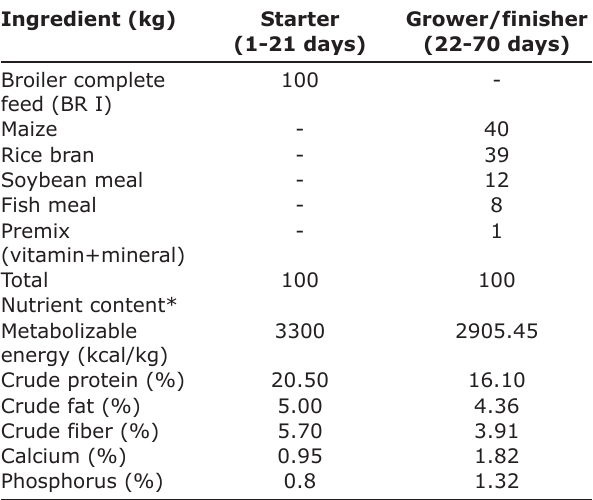
Table-1: Ingredient and nutrient composition (g/kg) of diet for ducks (air-dried basis). Ingredient (kg) Starter (1-21